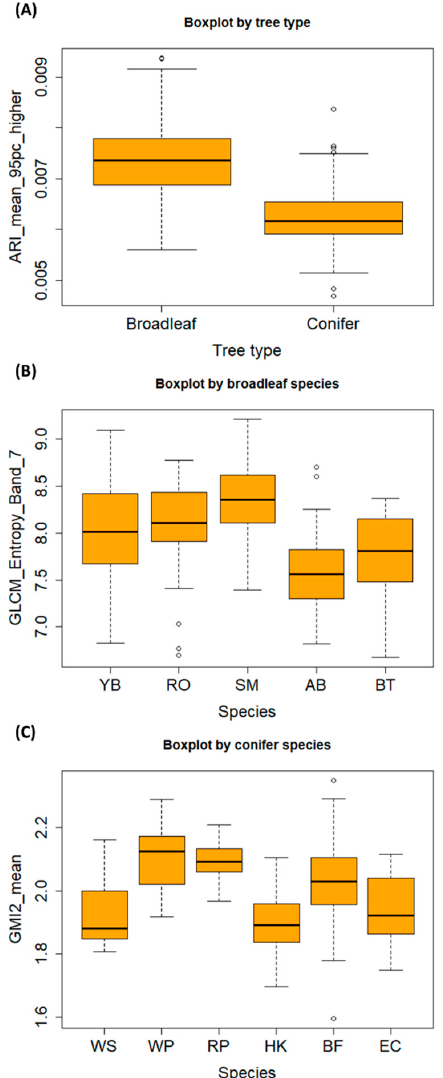
Figure Figure 6. Boxplots of the ( A ) ARI_mean_95pc_higher index; ( B ) GLCM_Entropy_Band_7; and ( C ) GMI2_mean index for tree types, broadleaves and conifers, respectively. The species’ abbreviations and the number of training samples used to calculate the mean are described in Table 2. The variables’ abbreviations are described in Appendix A.